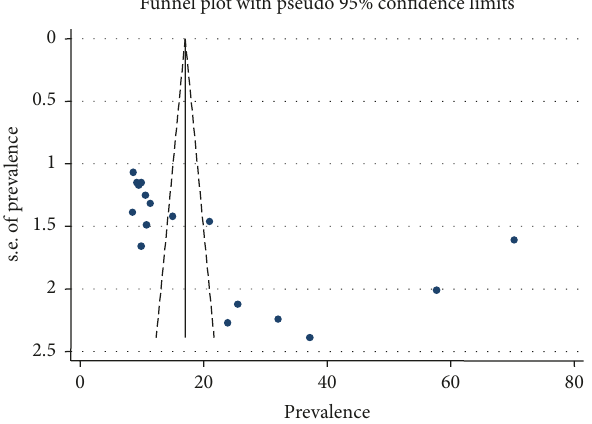
Filled funnel plot with pseudo 95% confidence limits